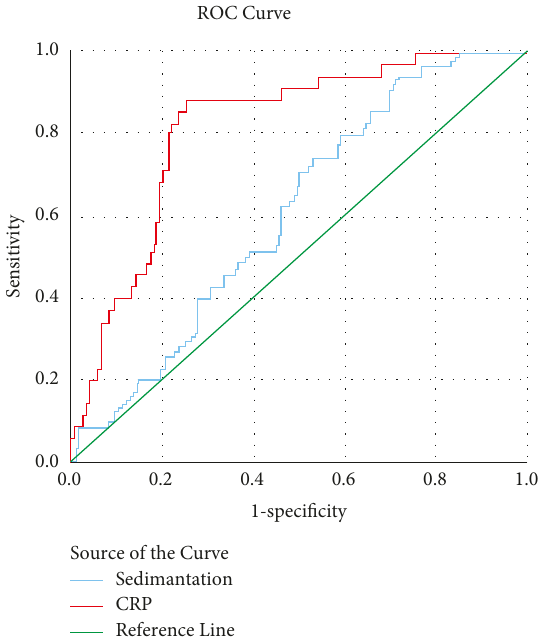
Figure 2: ROC curves for the prediction of mortality by sedi- mentation and CRP.